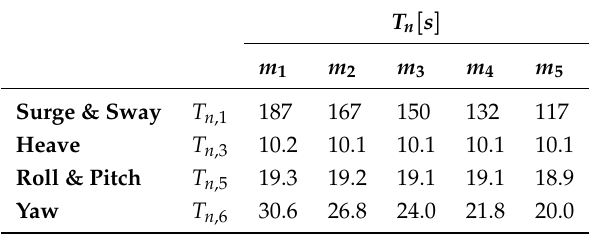
Table 5. Natural periods from free decay tests for different mooring configurations, as in Table